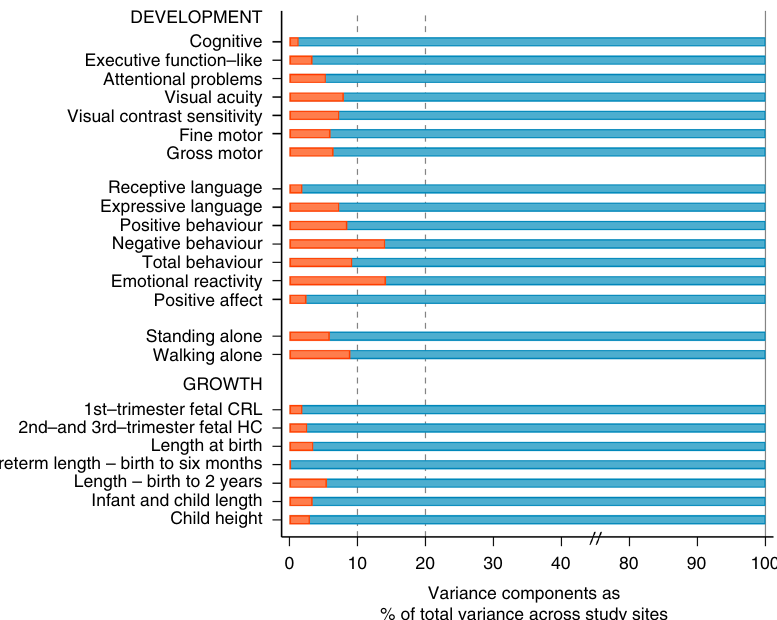
Fig. 3 Variance components analysis of 16 neurodevelopmental domains evaluated in the present study (upper part) and variance components analysis of 7 measures of fetal, newborn, infant and child growth (lower part). Red bars are the % of total variance explained by between sites variability for each domain or growth measure. Data for the seven growth measures: INTERGROWTH-21 st Project (eight study sites) 2,3,5,9 ; WHO Multicentre Growth Reference Study ( fi ve study sites) 8 ; Habicht et al.